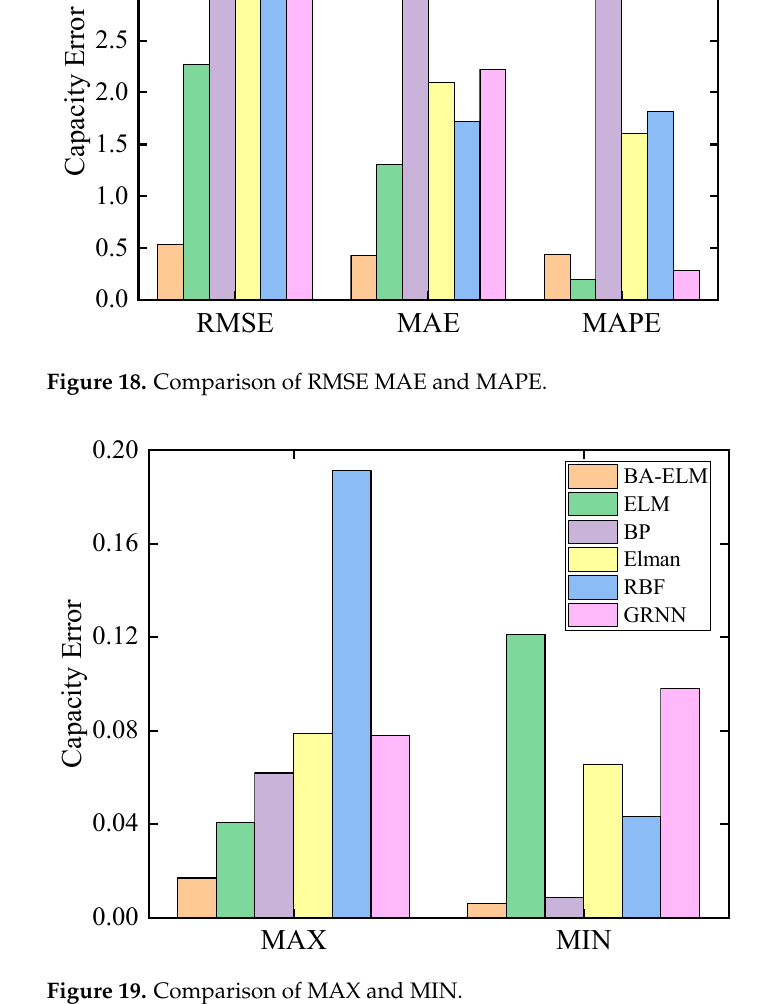
Figure 19. Comparison of MAX and MIN.